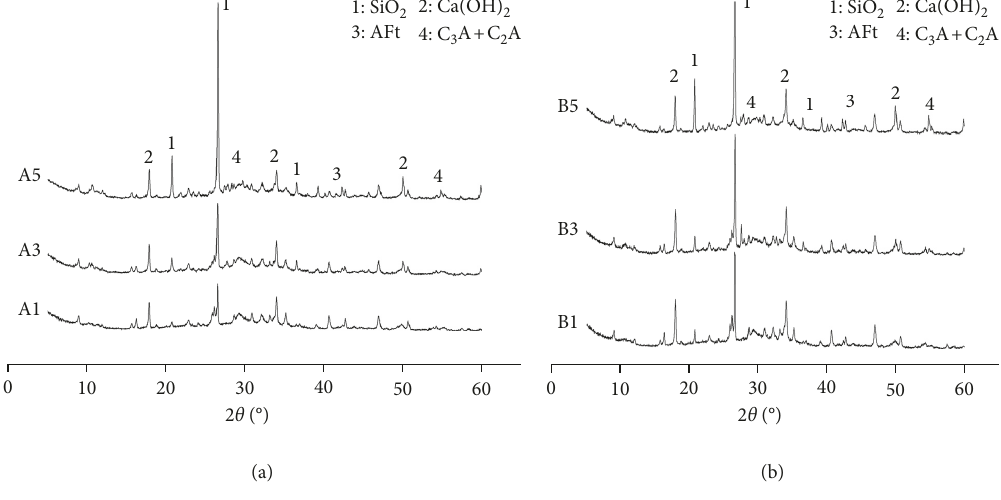
Figure 9: XRD of C30 and C50 concrete: (a) C30 and (b)